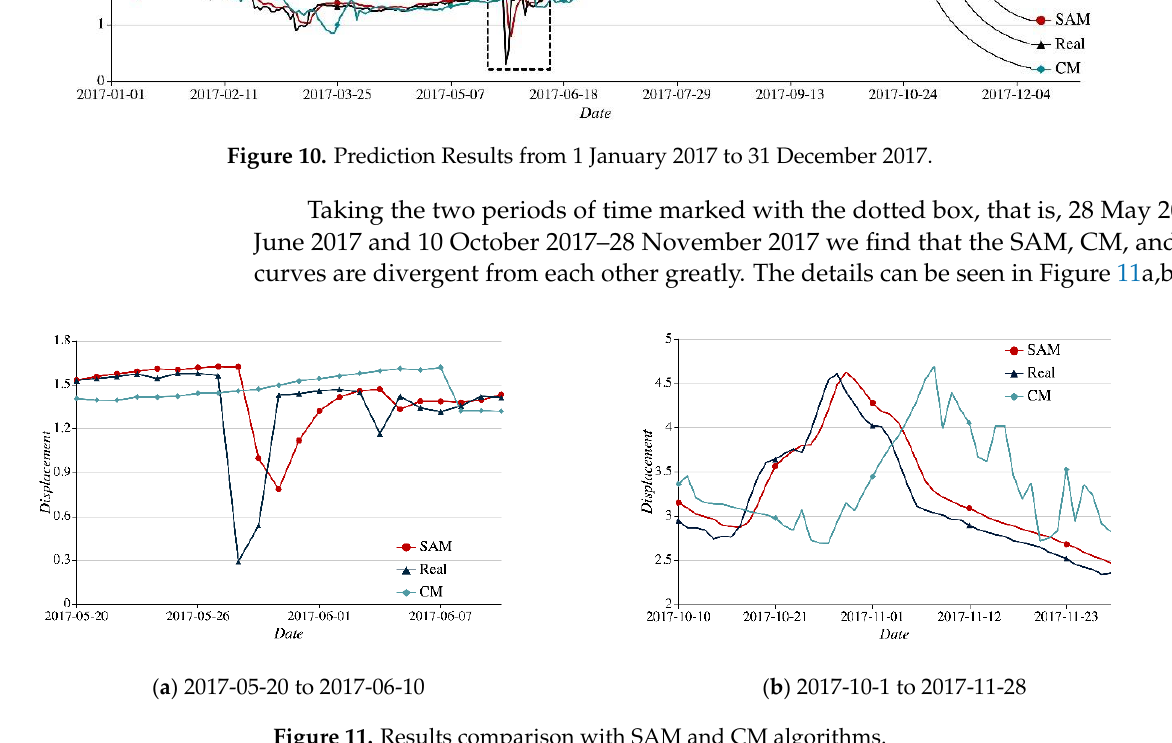
Figure 11. Results comparison with SAM and CM algorithms. I n Figure 11a, as the Real curve plunges on both 28 May 2017 and 4 June 2017 the CM curve takes on a trend of mild increase. However, the curve with SAM follows the Real